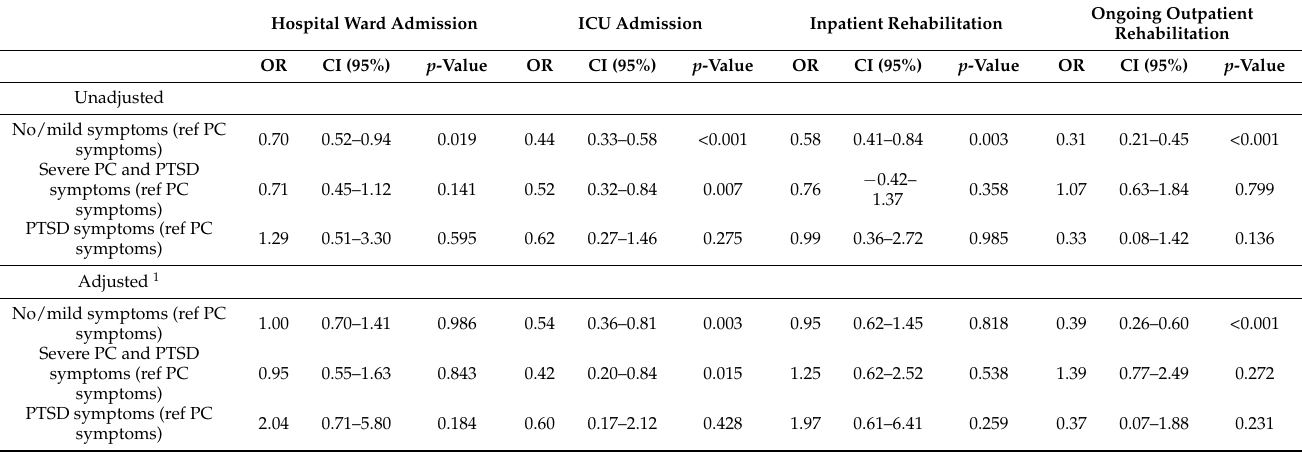
Table A2. Logistic regression analysis on health care utilization.